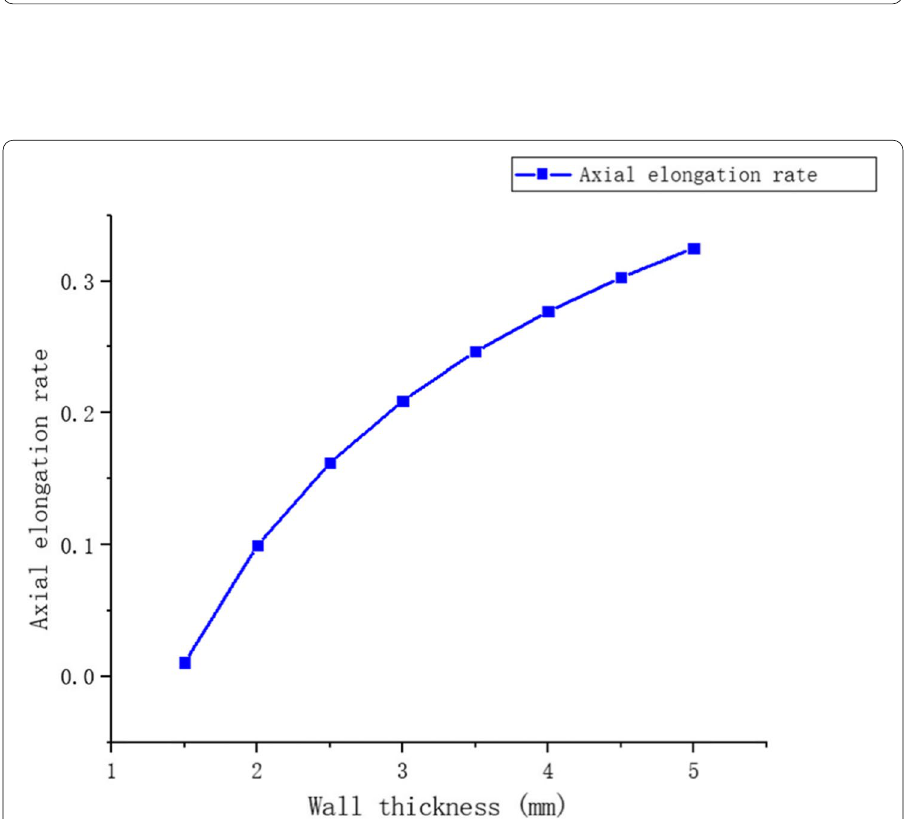
Fig. 8 The relation curve of axial elongation rate and wall thickness of rubber cylinder with uniform annular clearance